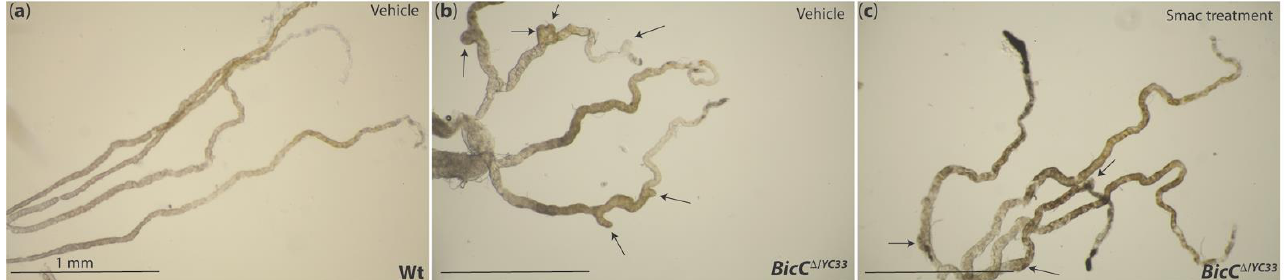
Figure 3. Cystic and non-cystic Drosophila Malpighian tubules. Malpighian tubules were micro-dissected ex vivo from synchronously cultured flies of the indicated genotype and photographed as described in [201]. ( a ) Representative Malpighian tubules micro-dissected from control wt flies treated with vehicle (water) are elongated and regularly shaped. ( b ) Tubules from BicC mutants ( BicC ∆/YC33 ) treated with vehicle developed several cysts (arrows), were abnormally thick and displayed apparent extra branching (lowest arrow). ( c ) BicC ∆/YC33 flies sibling to those in ( b ) treated with an active Smac mimetic had reduced cysts (arrows), both in number and size. BicC ∆/YC33 flies carry a BicC deletion ( Df(2L)RA5, ∆ ) in trans to a BicC hypomorphic allele ( BicC YC33 ). For a discussion of the BicC alleles see [166]. Scale bar: 1 mm.